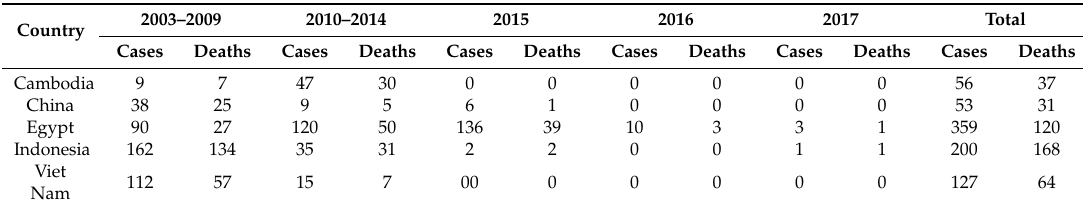
Table 3. Cumulative number of confirmed human cases for avian influenza A(H5N1) reported to WHO,